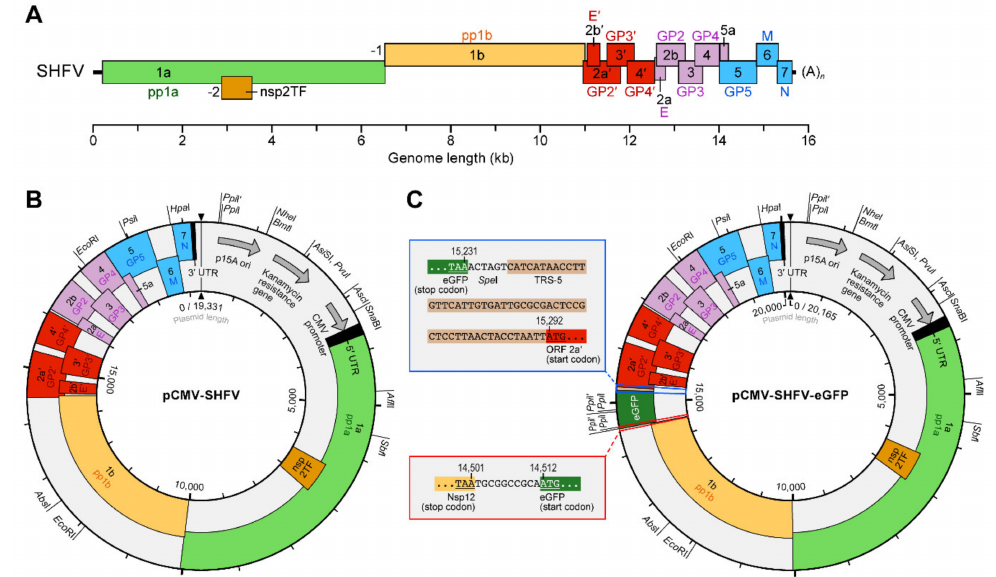
Figure 1. Schematics of simian hemorrhagic fever virus (SHFV) cDNA-launch infectious clones. ( A ) The SHFV genome is a linear, unsegmented, polyadenylated, positive-sense RNA. Open reading frames (ORFs) are shown as colored rectangles. ORF1a is translated directly from the genomic RNA into polyprotein 1a (pp1a). A -2 programmed ribosomal frameshift results in nonstructural protein 2 transframe (nsp2TF), whereas a -1 frameshift fuses ORF1a and ORF1b, resulting in polyprotein 1ab (pp1b). pp1a and pp1ab are co- and post-translationally cleaved to yield numerous SHFV nonstructural proteins (nsps). The remaining ORFs encode the SHFV structural proteins, which are translated from a nested set of subgenomic RNAs. E, envelope protein; GP, glycoprotein; M, matrix protein; N, nucleocapsid protein. ( B ) Constructed plasmid pCMV-SHFV, encoding wild-type SHFV. ( C ) Constructed plasmid pCMV-SHFV-eGFP, encoding